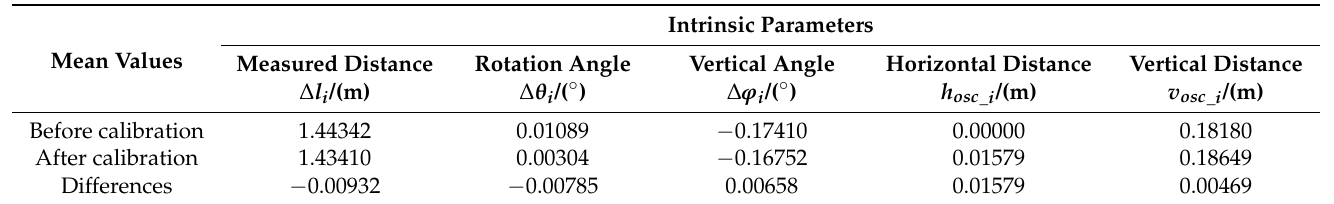
Table 2. The mean values and differences in five intrinsic parameters for the 64 laser beams.